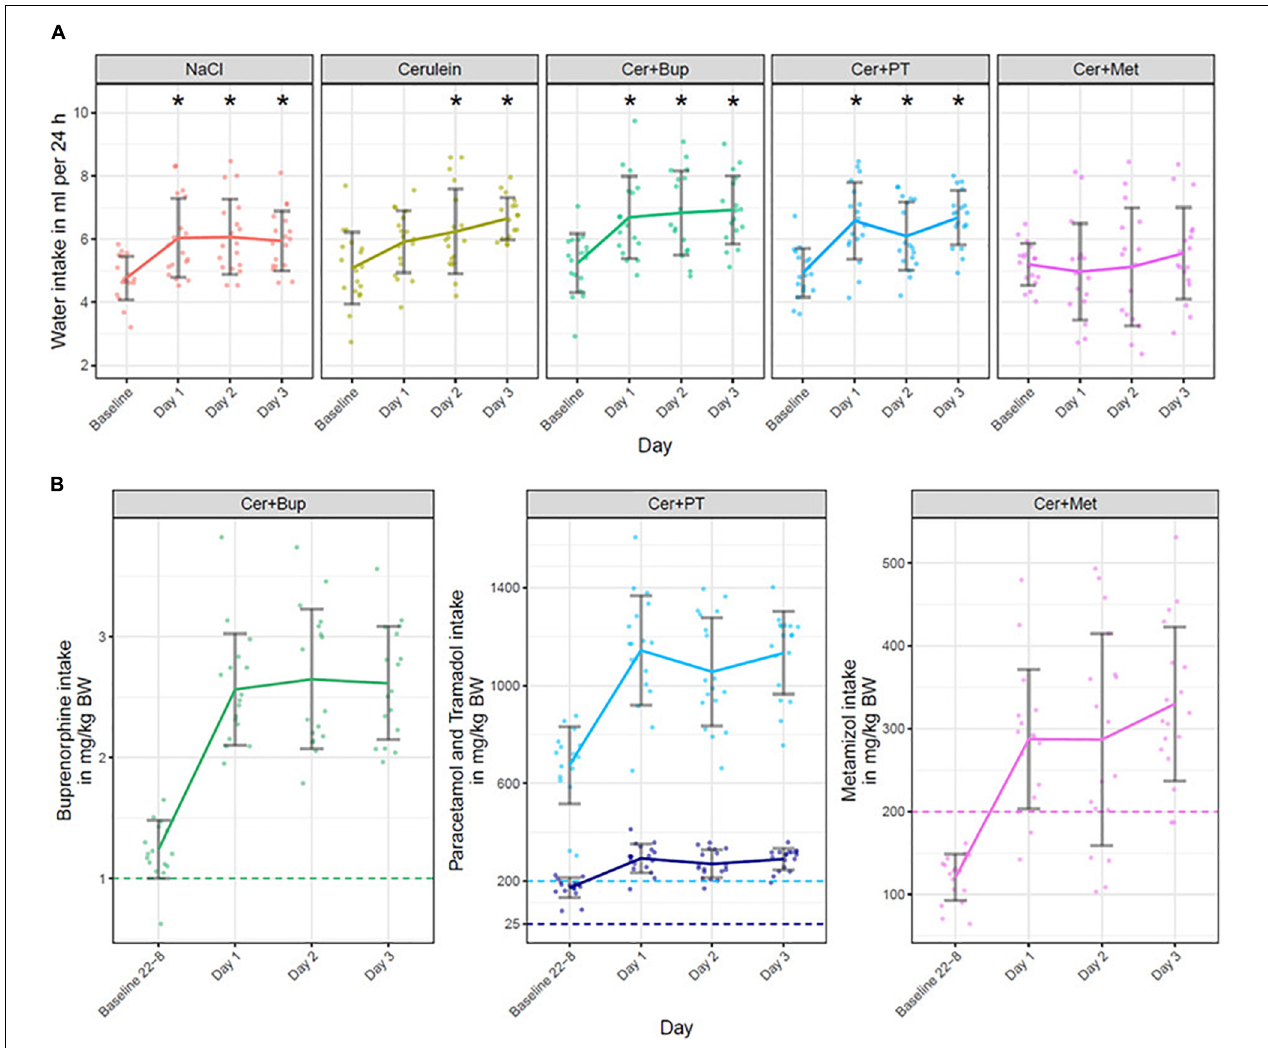
FIGURE 3 | (A) Water intake in ml per 24 h is displayed for baseline (untreated water) and on Days 1, 2, and 3 (treated water). Bonferroni corrected post hoc test showed that on Day 1, Cer + Met had a significantly lower water intake than NaCl and Cer, and water intake in Cer + PT was lower than in Cer. On Day 2, water intake in Cer + Met was significantly lower than in NaCl, Cer, and Cer + Bup. On Day 3, Cer + Met had a significantly lower water intake than all other treatment groups. * Significant ( p ≤ 0.05, Dunnett’s post hoc ) differences to the baseline water intake within one treatment group. (B) Analgesia intake presented for each substance in the different treatment groups. Note that the Cer + PT group received a combination of Paracetamol (light blue) and Tramadol (dark blue). The intake is displayed in mg/kg body weight during the night before the first Cerulein injections (22:00 to 8:00, Baseline 22-8), during the 24 h of the first day of injection (Day 1), during the 24 h of the second day of injection (Day 2) and during the 24 h on the day following the injections (Day 3). The dashed line marks the dosage sought in mg/kg per 24 h. No statistical analysis was performed on the analgesia intake. Data are shown as scatter dot plot with mean ± SD, NaCl n = 18, Cer n =